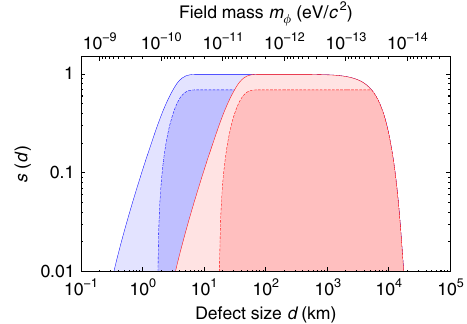
Fig. 8 Domain wall width sensitivity. Sensitivity, s , as a function of the wall width d . The blue region corresponds to the best case scenario (due to the servo-loop uncertainty), and the red region to the worst case, see Eq. (12). The darker regions correspond to a time window of size J w = 300 s (i.e., v min ≈ 170 km s − 1 ), and the lighter regions correspond to J w = 3000 s ( v min ≈ 17 km s − 1 ). The upper horizontal axis shows the mass of